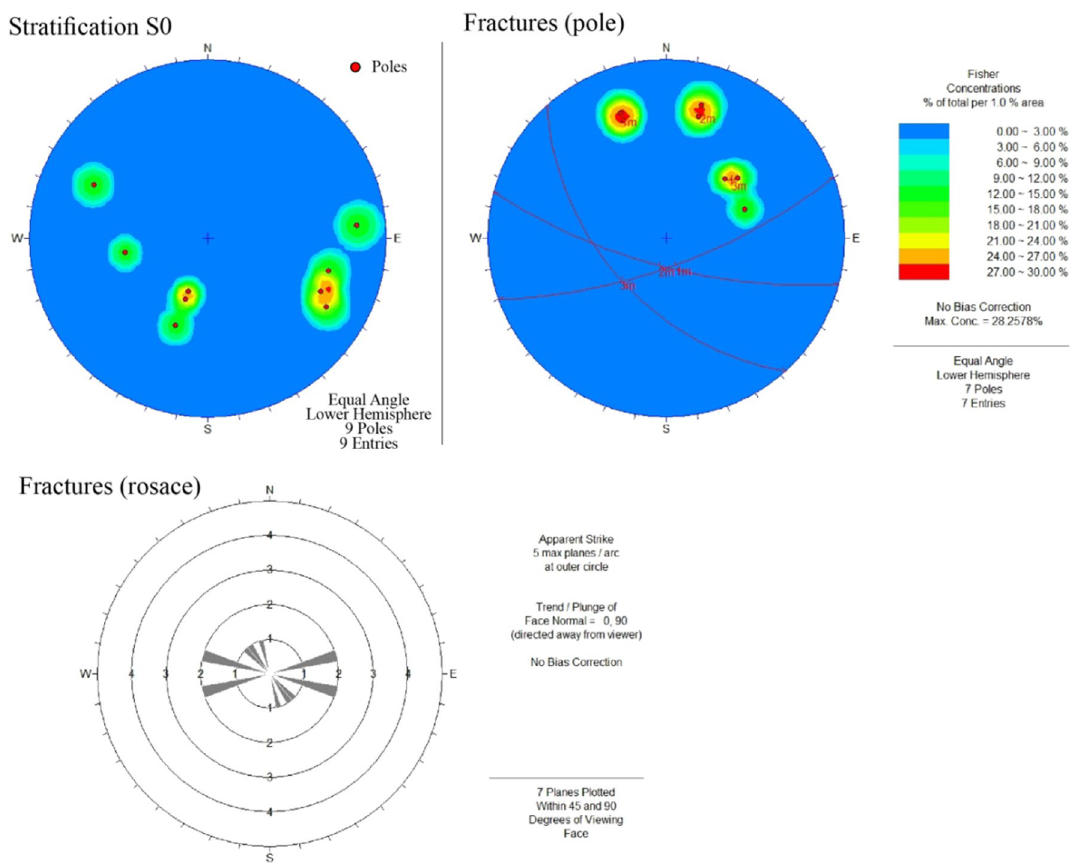
Fig. 8 Stereographic projection of tectonic measurements at the locality of Chebabate Fig. 9 Tahla limestone plateau dislocated by a series of NE-SW